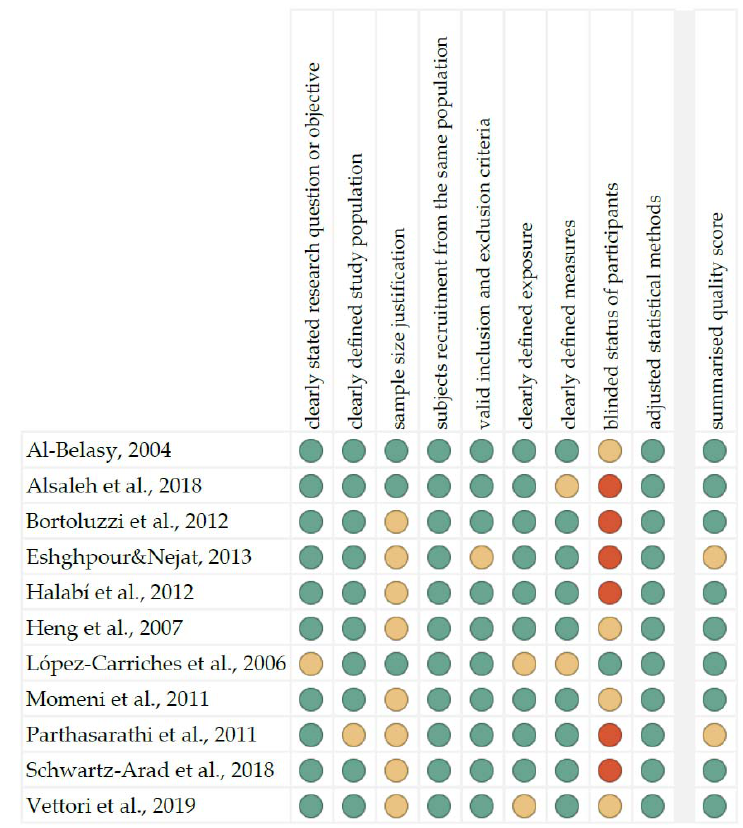
Figure 1. Quality assessment, including the main potential risk of bias (risk level: green—low, yellow— unspecified, red—high; quality score: green—good, yellow—intermediate, red—poor)